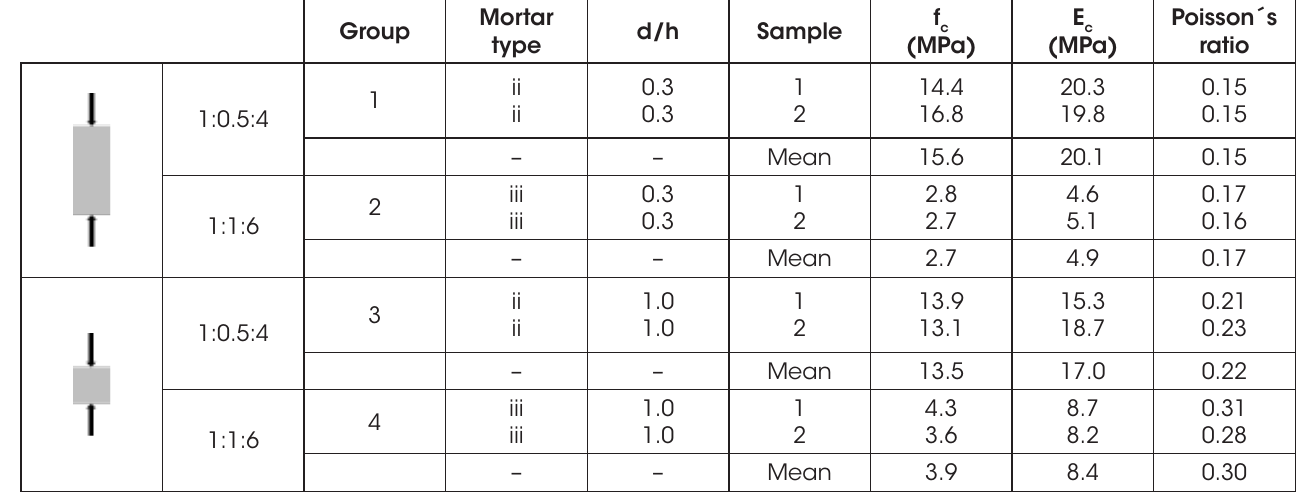
Mechanical characterisation of the mortar samples